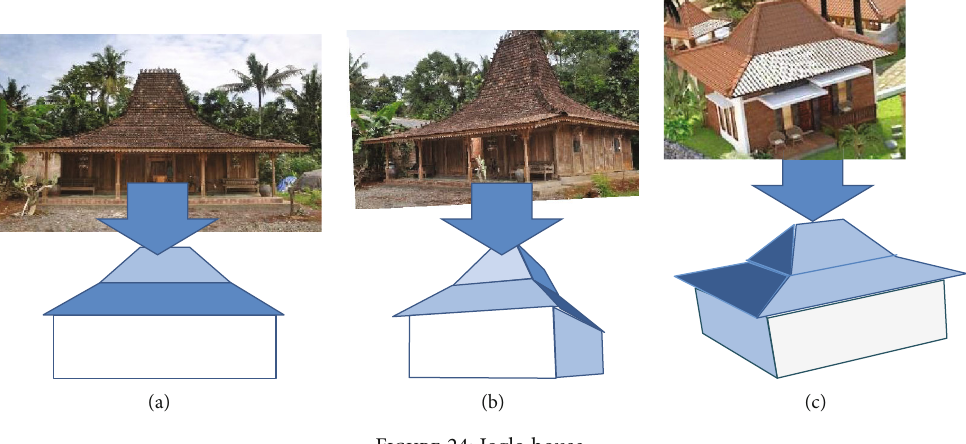
Figure 24: Joglo